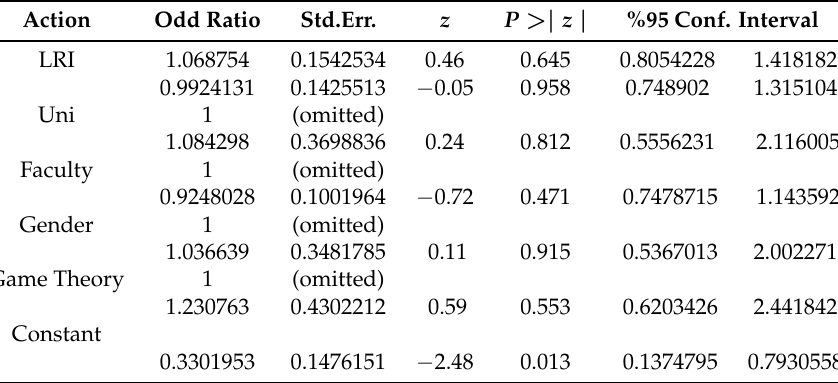
Table 7. Monopoly-Panel Logistic Regression